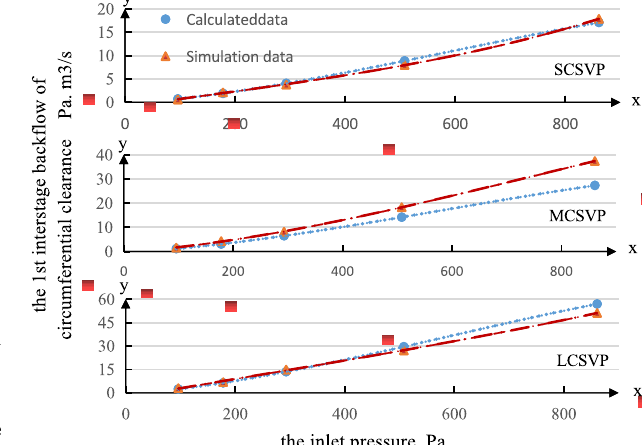
Fig. 15. Relationship between the 1st interstage back fl ow of circumferential clearance and inlet pressure.